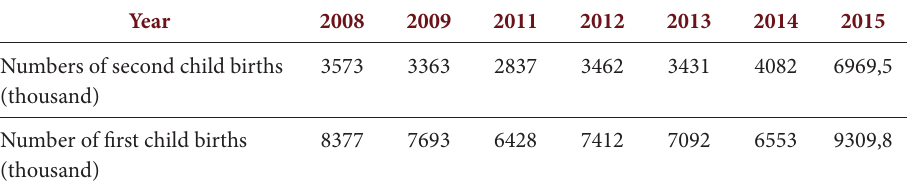
The data source: China National Bureau of Statistics. The data for 2015 is from the 1% sample survey data, and other data is 0.1% of the sample survey data of each province in China.